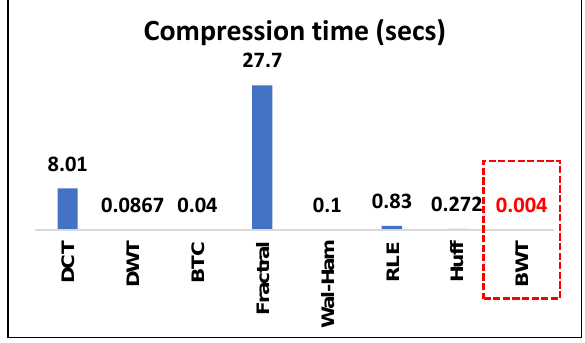
Figure 9. Performance on the basis of compressed time offered by different image compression algorithms Figure 10 represents the performance of the compression techniques on the basis of Decompression Time. DWT takes the minimum amount of time i.e., 0.0021 secs to decompress the image where DCT takes 0.015 secs. BTC decompresses